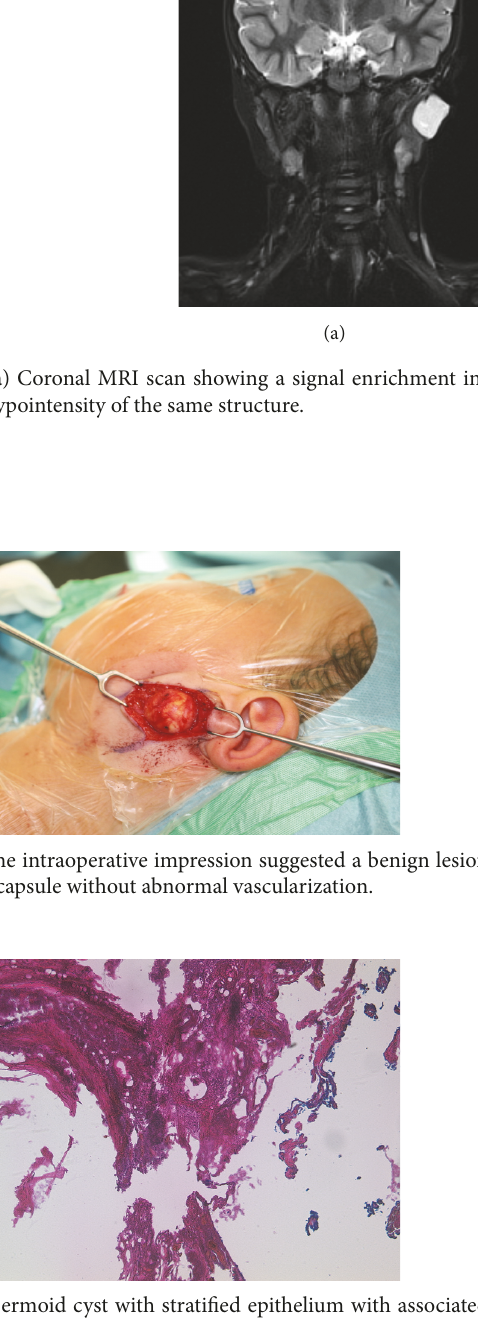
needle aspiration cytological features of dermoid cyst of